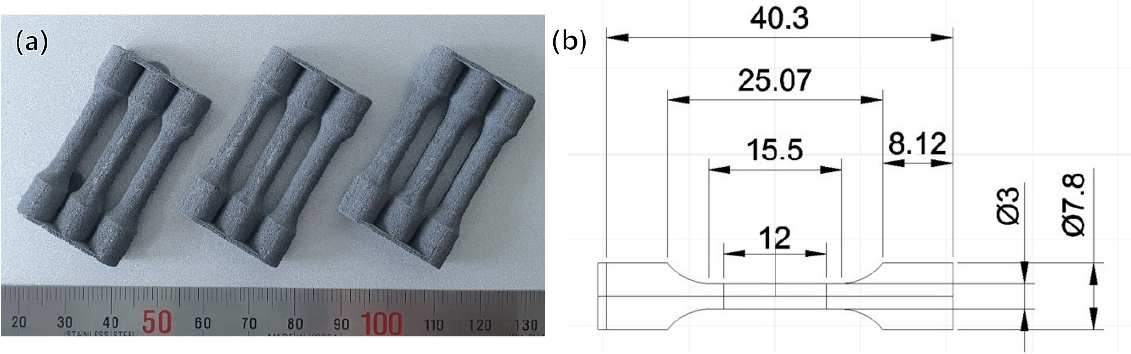
Figure 1. ( a ) As-built specimens, ( b ) geometry of dog-bone specimen (dimension in mm).